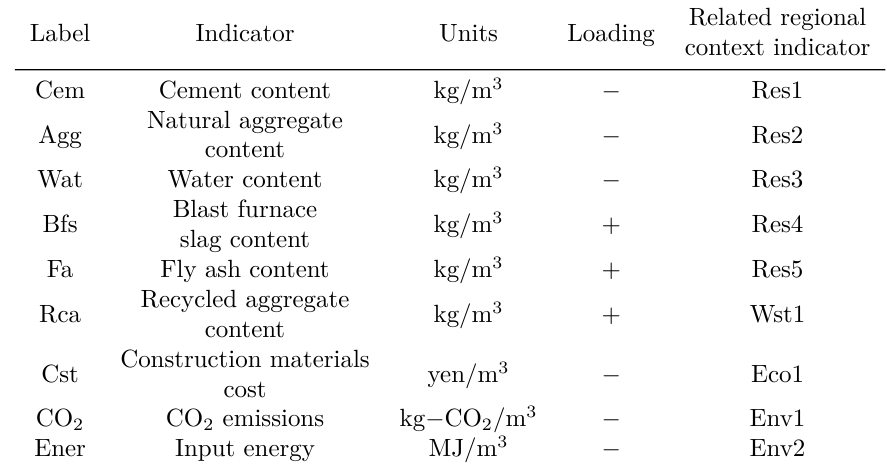
Table 5. Indicators for concrete sustainability evaluation.